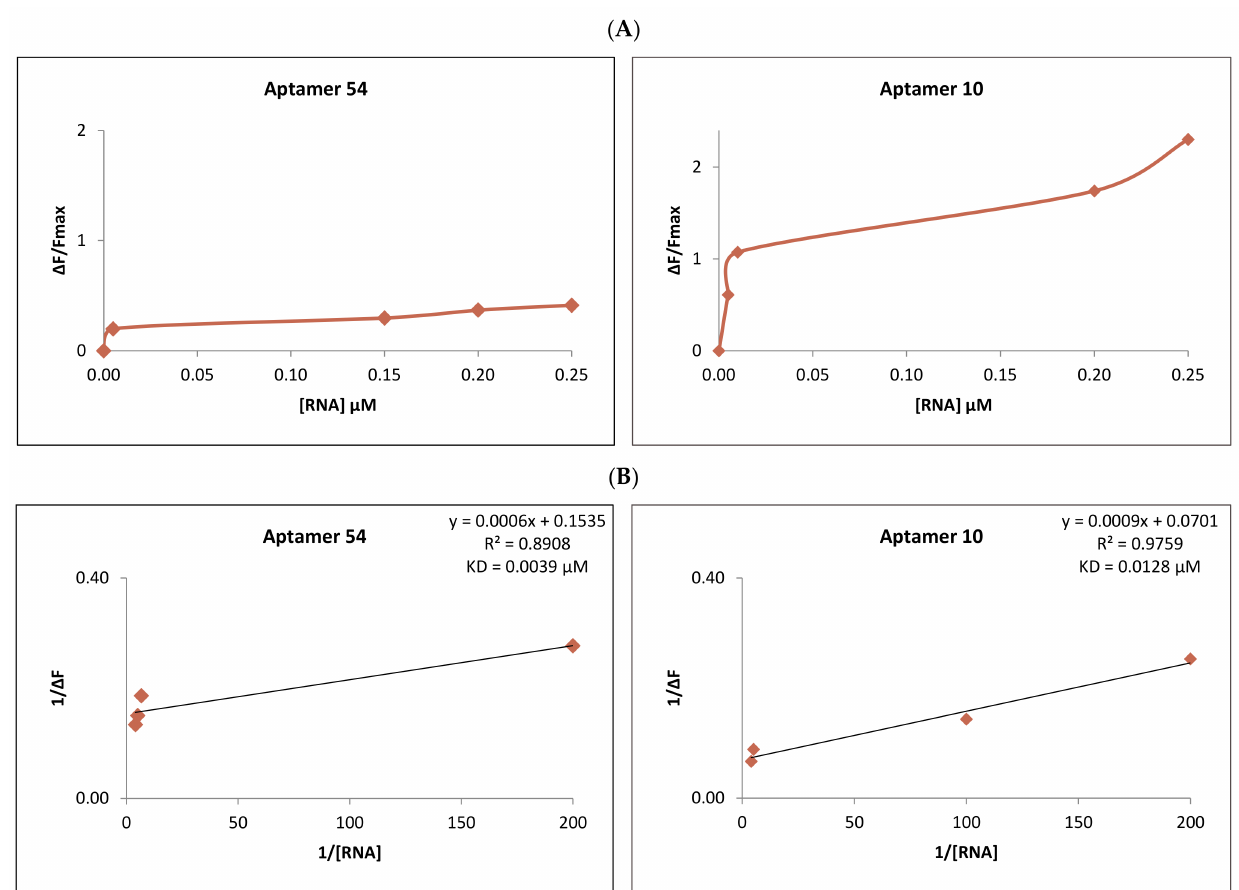
Figure 5. Comparison of the interaction of the strongest binding aptamer, RNA 54 (left), and the least strong, RNA 10 (right), to purified exosomes. ( A ) Change in the fluorescence of exosome-bound CTB-555 and fDiI during titration with RNA aptamer 54 (left) and RNA aptamer 11 (right). F max is the maximal CTB-555 and fDiI fluorescence obtained before titration with RNA acceptor. ∆ F is the difference between measured fluorescence and F max . ( B ) Reciprocal of CTB-555 and fDiI fluorescence change during titration with RNA aptamer 54 (in left) and aptamer 10 (right). The regression line equation and the coefficient of determination (R 2 ) are noted above the calculated K D value in the top-right corner of the